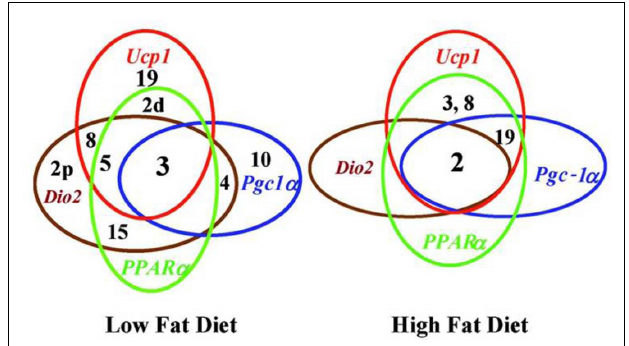
FIGURE 5 |Venn diagrams for chromosomes and gene expression illustrate the overlap of selective chromosomes in regulating genes associated with the regulatory network controlling Ucp 1 function. Diagram also underscores the profound effects of diet on genes associated with regulatory networks of Ucp 1 expression. Numbers refer to chromosomes carrying QTLs and those enclosed within a circle indicate those QTL associated with regulation of the indicated